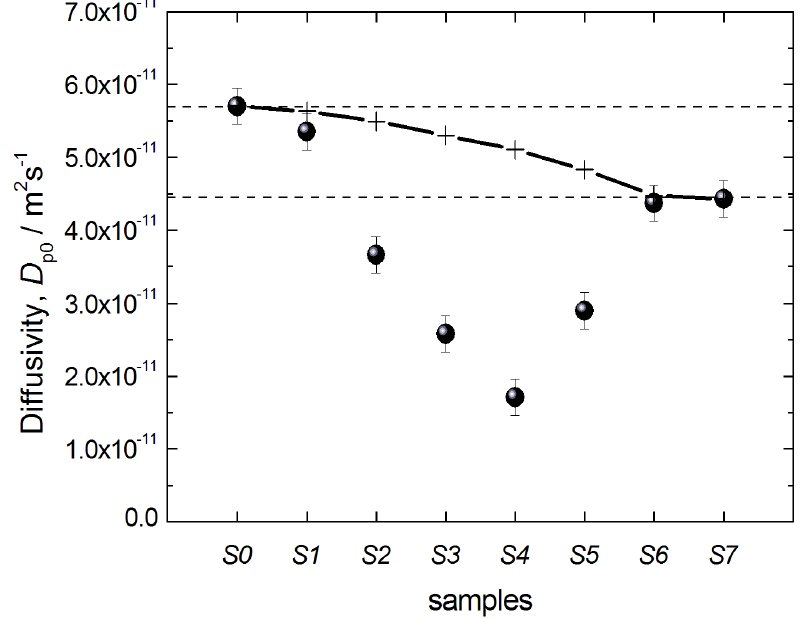
D of n-heptane in the initial silica gel S0 and the Figure 11. Effective diffusivities 0 p transformation products S1–S7. The crosses and the solid line show the prediction of the two-region model (see text for